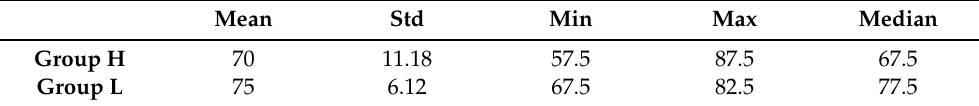
Table 5. SUS scores for both the group with high/medium skill in MR (Group H) and that with low skill (Group